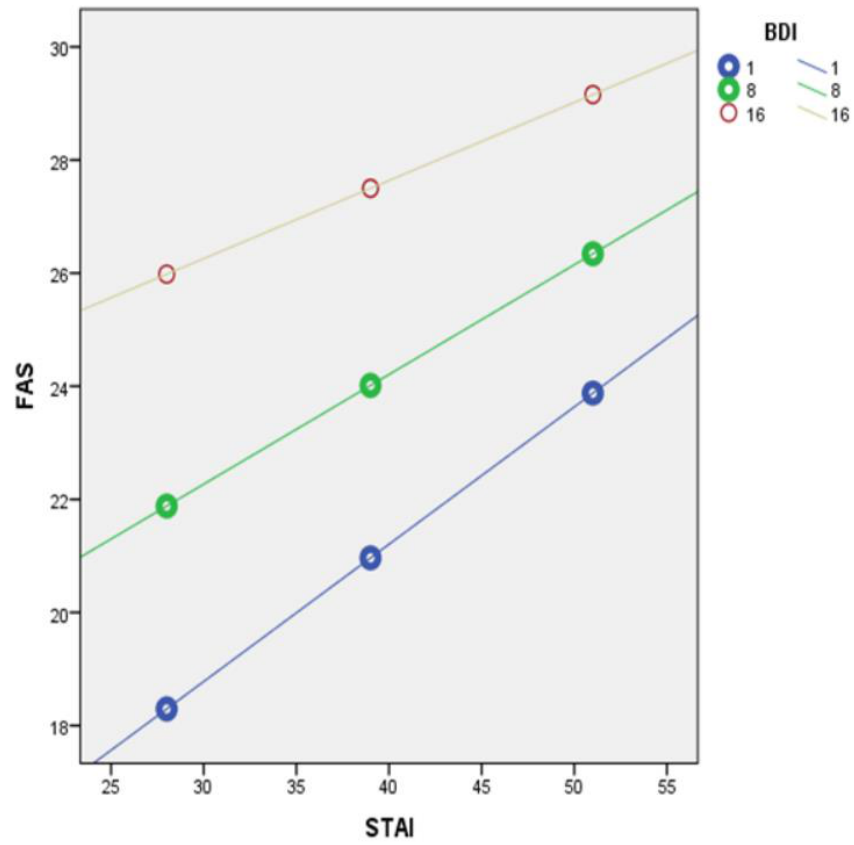
Figure 2. Beck Depression Inventory (BDI) as a moderator of the relationship between Spielberger Trait Anxiety Inventory (STAI) and Fatigue Assessment Scale (FAS), at low (1), middle (8) and high (16) degrees of BDI.